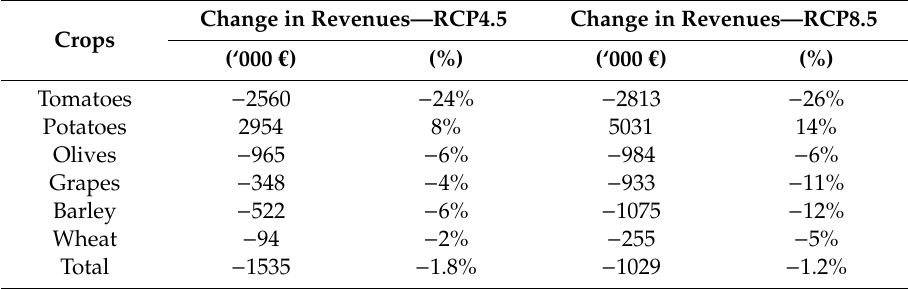
Table 14. Change in the expected total revenues per crop for the two main climatic scenarios. Change in Revenues—RCP4.5 Change in Crops